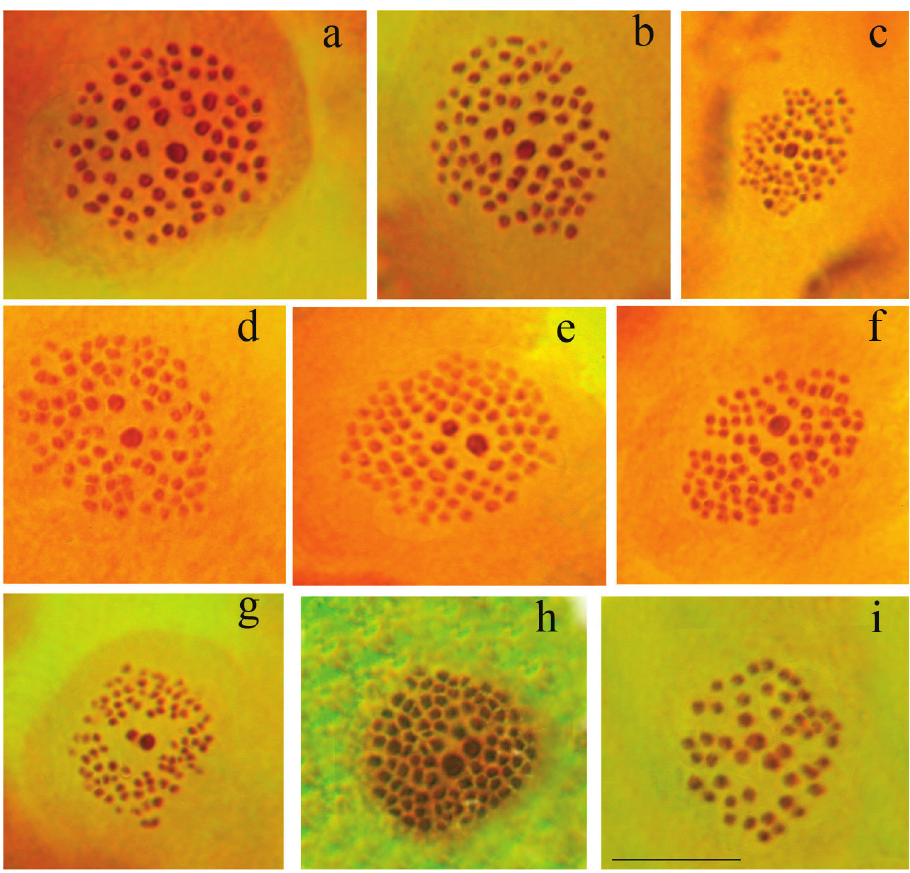
Figure 3. Polyommatus ( Agrodiaetus ) karyotypes. Bar =10 µ. a–b P . admetus , sample LR08D109, Greece, MI, n=80. One large bivalent in the centre of the plate can be seen c P . admetus , sample LR08D109, Greece, MII, n=80. One large chromosome in the centre of the plate can be seen d P . ripartii pelopi , sam- ple LR08D249, Greece, MI, n=90. Two large bivalents in the centre of the plate can be seen e P . ripartii pelopi , sample LR08D144, Greece, MI, n=90. Two large bivalents in the centre of the plate can be seen f P . ripartii pelopi , sample LR08D145, Greece, MI, n=90. Two large bivalents in the centre of the plate can be seen g P . ripartii pelopi , sample LR08D92, Greece, MII, n=90. Two large chromosomes in the centre of the plate can be seen h P . nephohiptamenos , sample LR08D494, Northern Greece, MI, n=90. All the bivalents are situated in a plane with the largest elements in the centre of the circular metaphase plate. Bivalents are clearly separated from each other by gaps. Two bivalents are larger than the rest. i P . aroaniensis , sample LR08D102, Greece, MI,